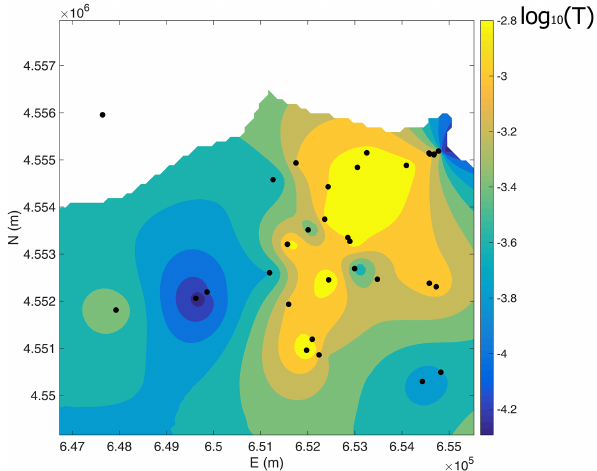
Figure 5. Ordinary Kriging interpolation of log 10 ( T ).